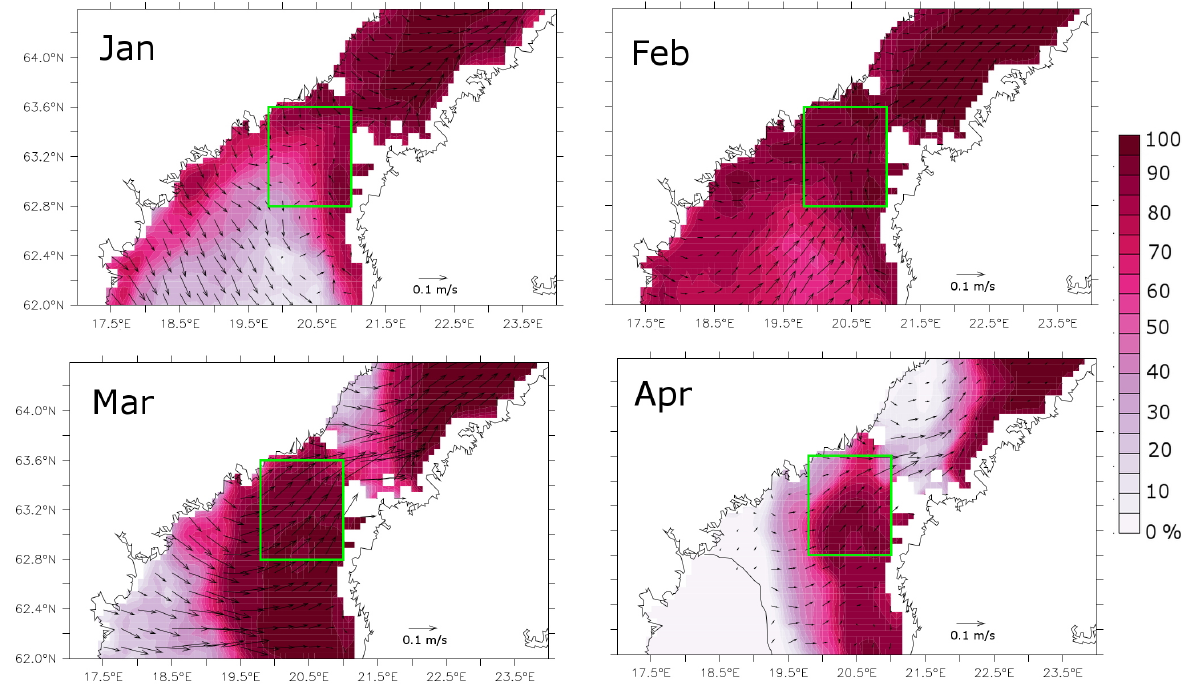
Figure 2. (a) – (d) Forecasted monthly mean ice concentration and ice drift in winter 2011. The squares mark the test region considered in this